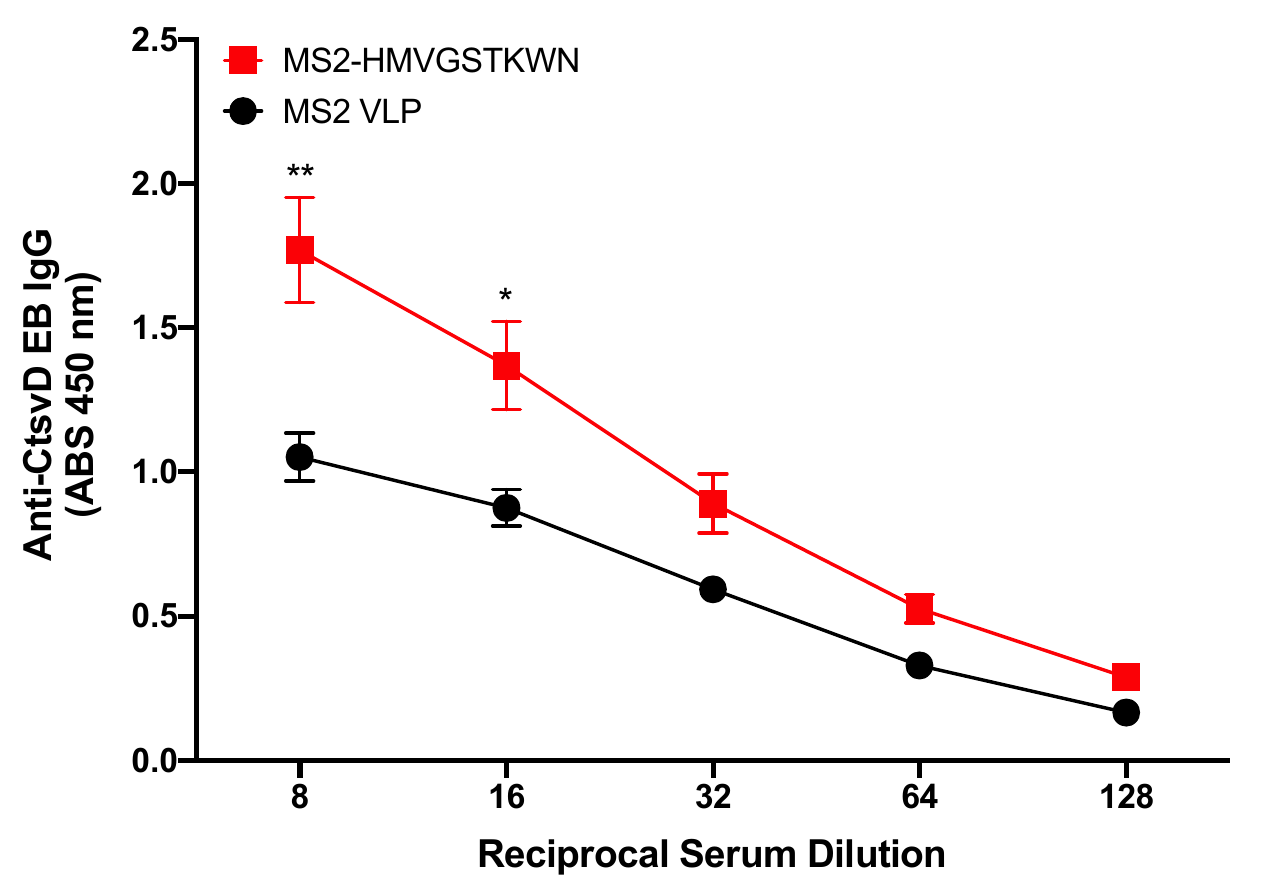
Figure 3. Binding characteristics of MS2-HMVGSTKWTN immunized mouse sera IgG to Ct serovar D. Mice ( n = 5) were immunized with MS2-HMVGSTKWTN or WT MS2 (negative control). Sera were collected, and binding activity was assessed against Ct serovar D by EB ELISA. Statistical anal-